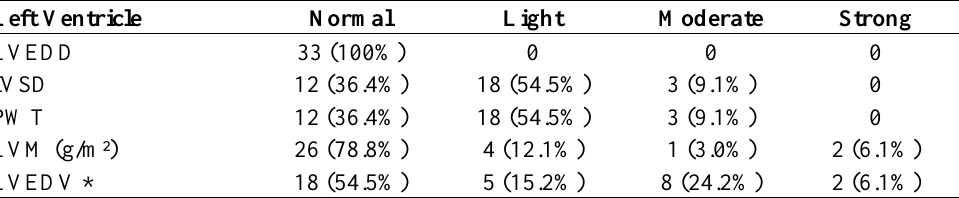
Table 3. Myocardial hypertrophy in female triathletes.